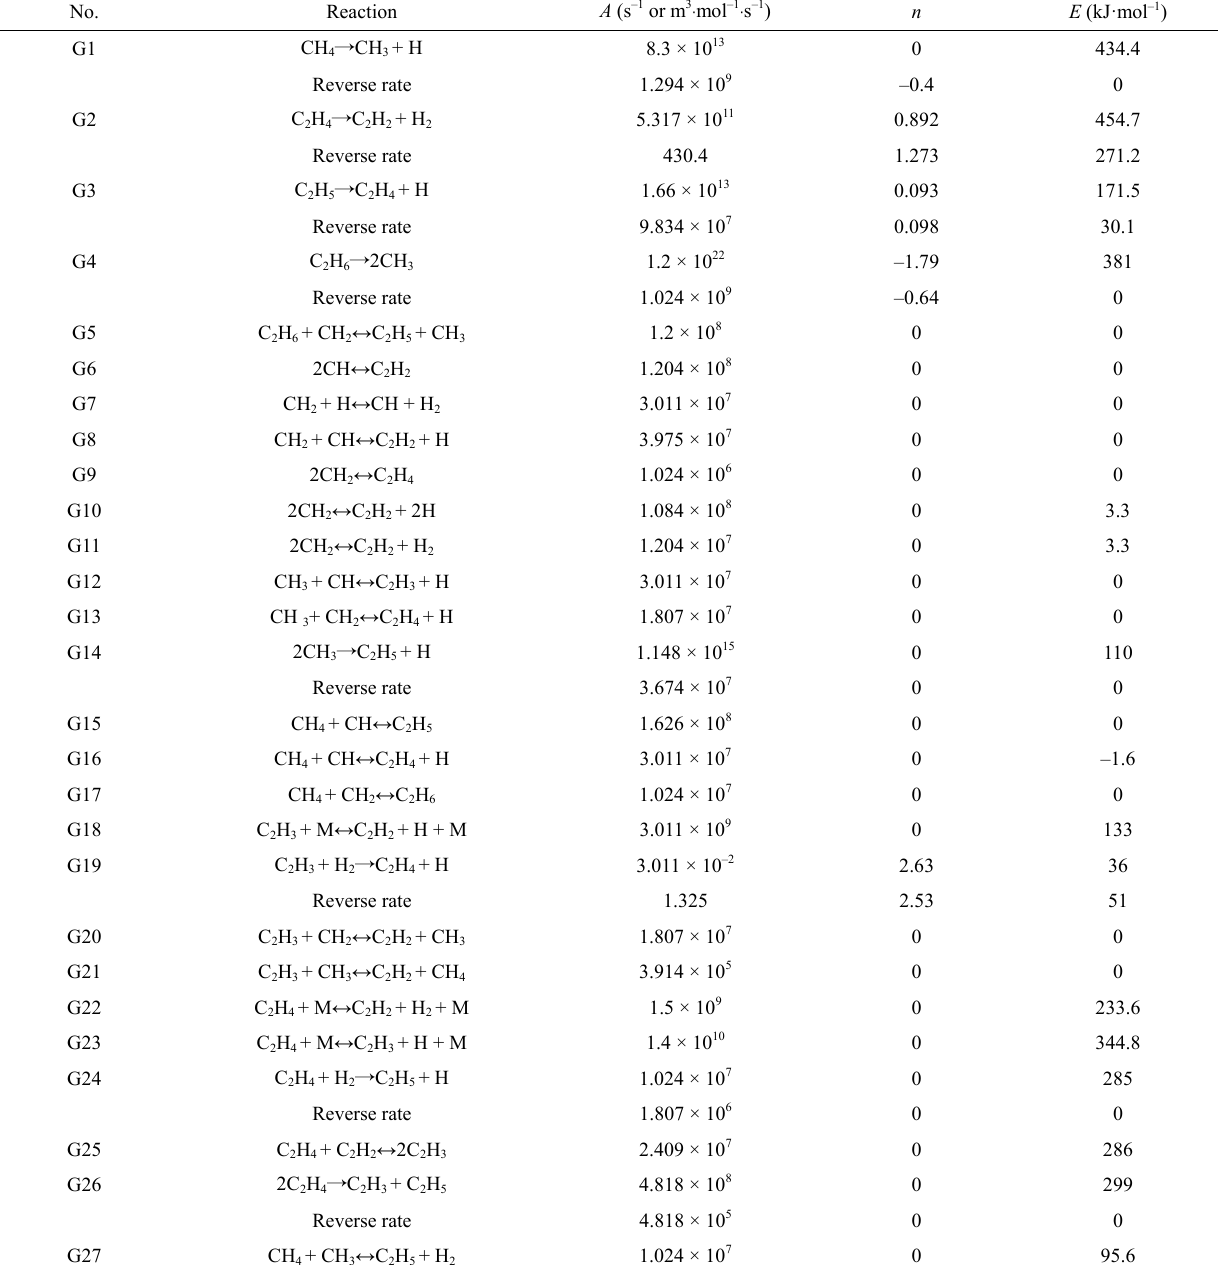
Table 3 A list of gas phase reaction